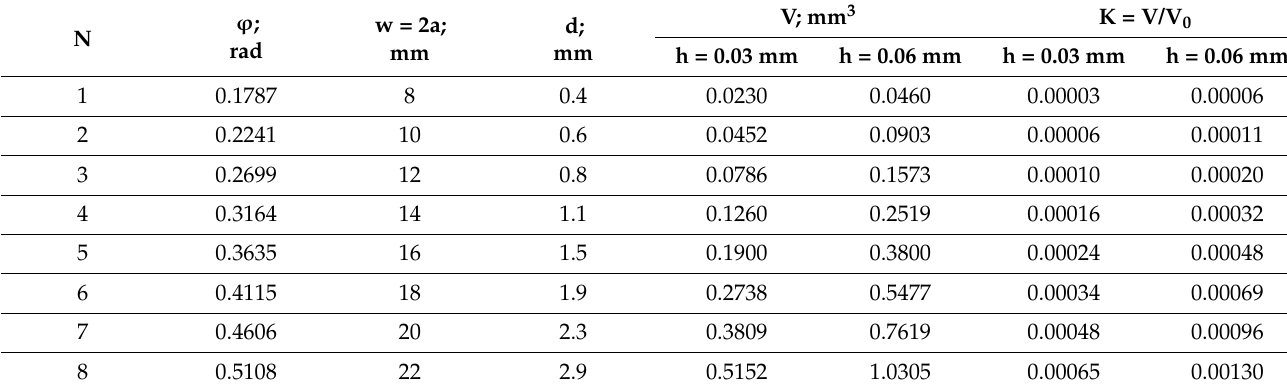
Table 2. Parameters of perimetral